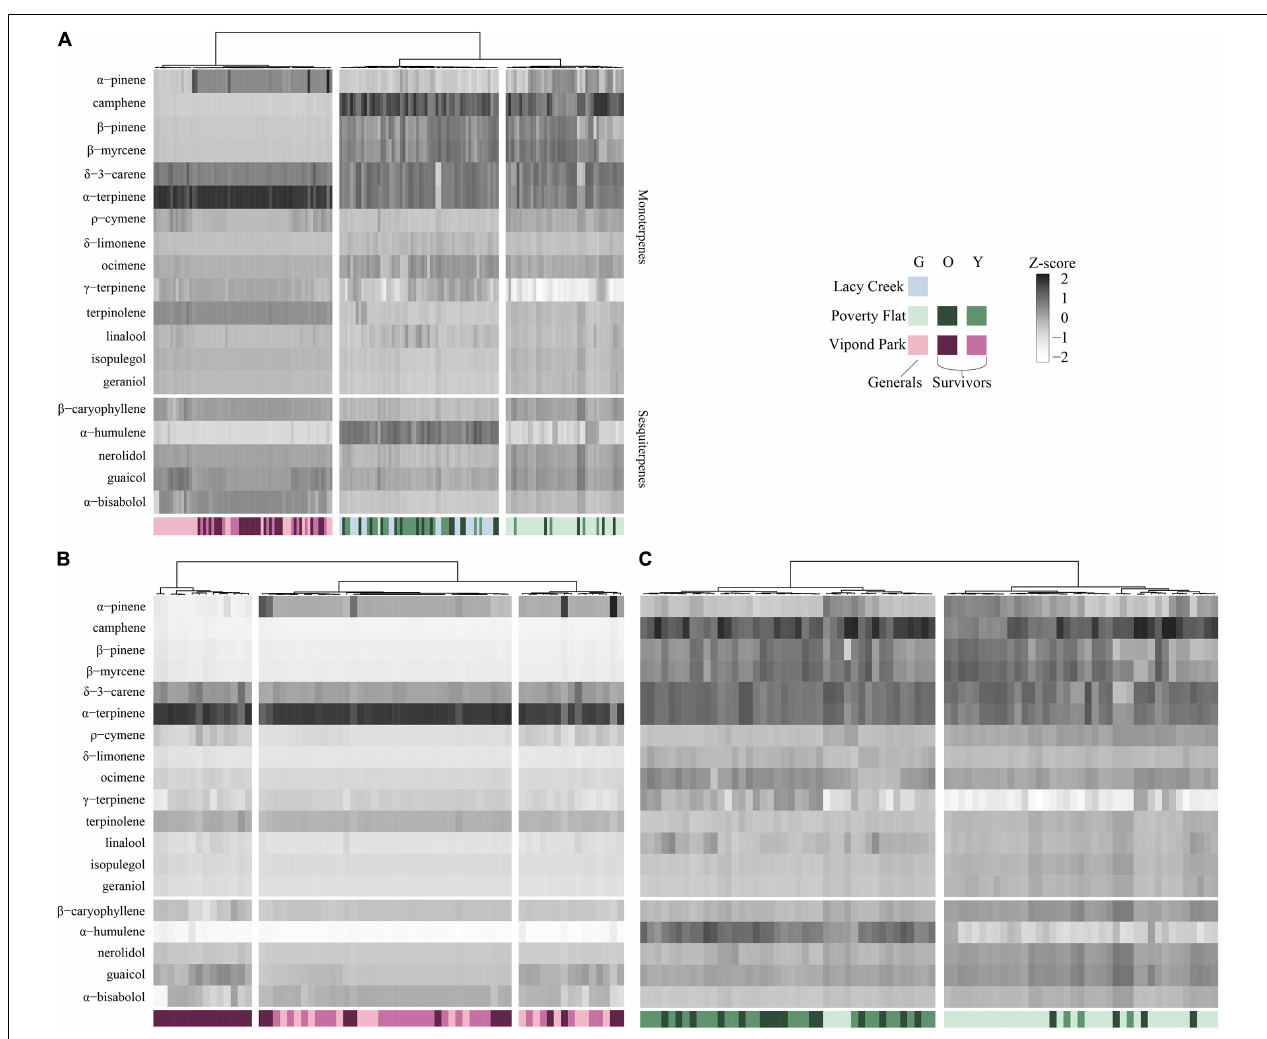
FIGURE 3 | Hierarchal clustering (HCA) of major compounds for generals and survivors for (A) all three sites; (B) Vipond Park; and (C) Poverty Flat. Community composition corresponds to the logit-transformed proportional composition. Grayscale intensity denotes relative concentration of each compound ( z -standardized). Color denotes site and color intensity corresponds to generals (lightest tint), older survivors (darkest tint), and younger survivors (medium tint). The number of column splits was determined by k-means clustering. Each vertical bar represents a tree.